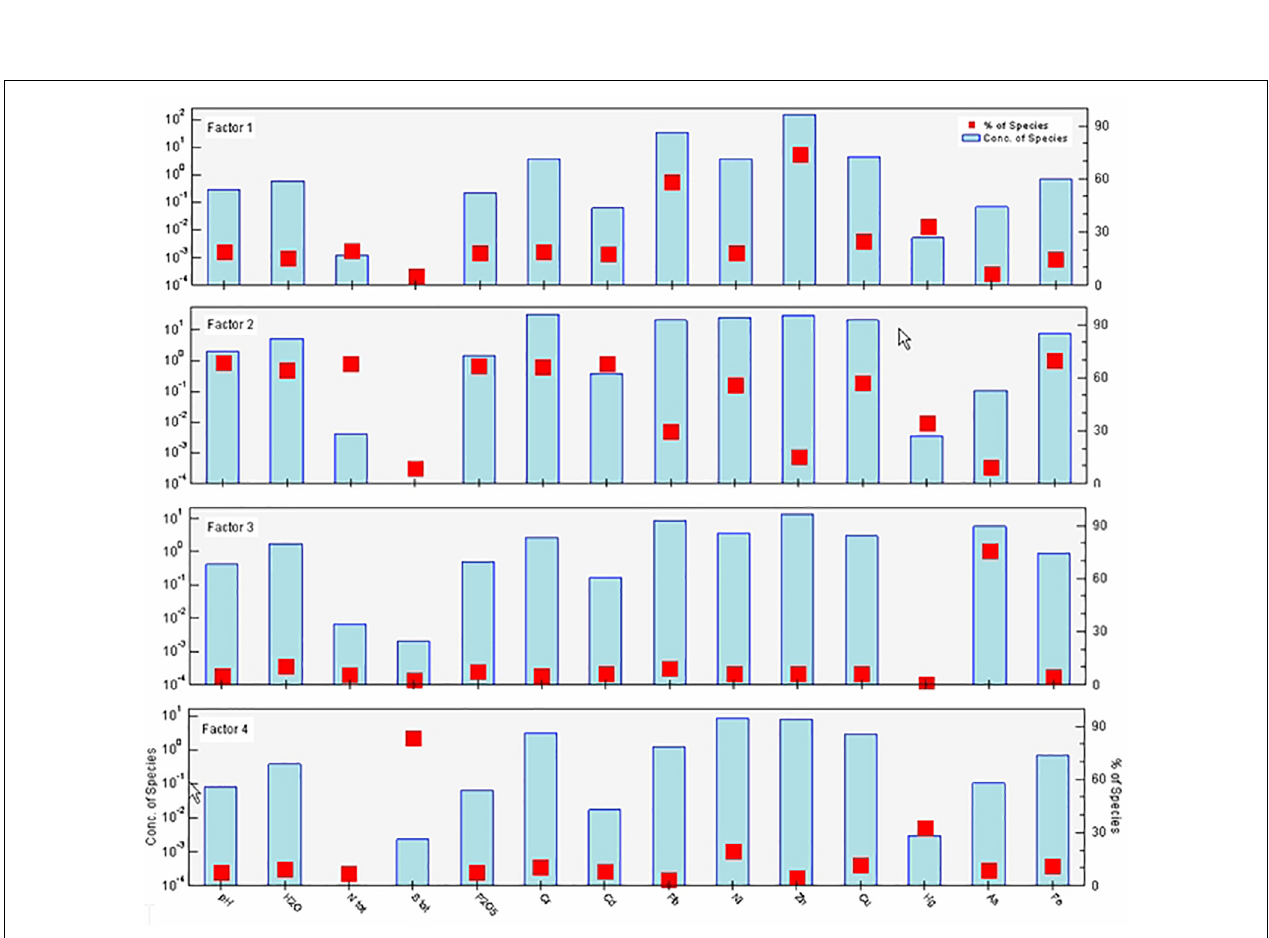
FIGURE 5 | Source profiles of metals and other analytes and source contribution percentages from the PMF model.